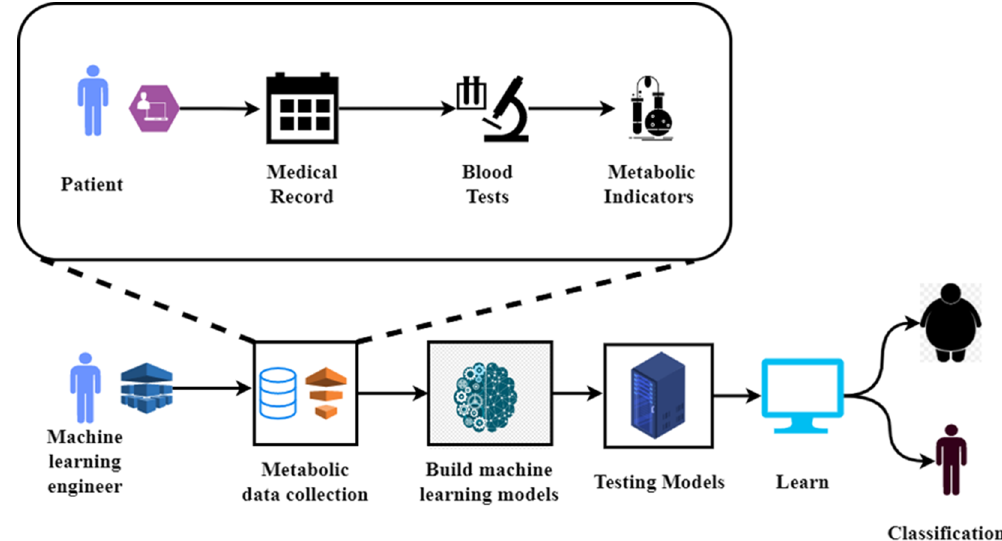
Figure 1. Metabolic syndrome diagnosis using machine learning.